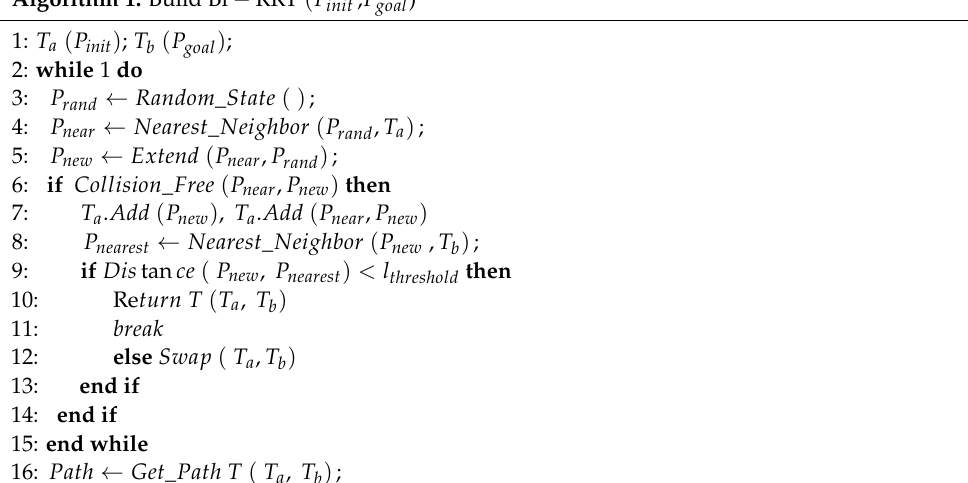
Algorithm 1: Build Bi − RRT ( P init , P goal )